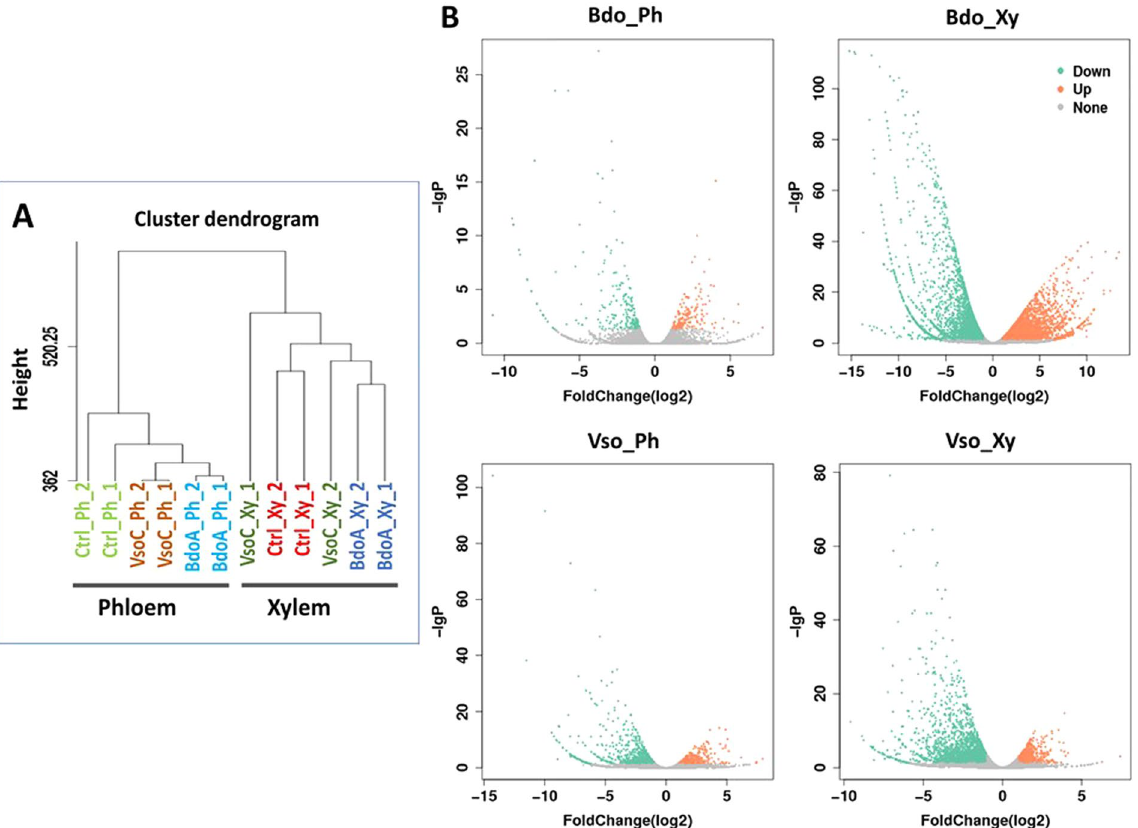
Figure 1. Global evaluation of transcriptome sequencing data of poplars infected by Botryosphaeria and Valsa canker pathogen. ( A ) Hierarchical clustering analysis of gene expression shown the consistency of two biological replicates in 6 groups (Bdo_Ph, Bdo_Xy, Vso_Ph, Vso_Xy, Ctrl_Ph and Ctrl_Xy). ( B ) Volcano map showing that the majority of DEGs are downregulated in pathogen-infected poplar stems. DEGs were selected using log 2 FC ≥ or ≤− 1 and FDR ≤ 0.05 including those only expressed in one library, and FDR < 0.05. Bdo_Ph, Bdo_Xy, Vso_Ph and Vso_Xy represent these four treatments compared to their controls, respectively.